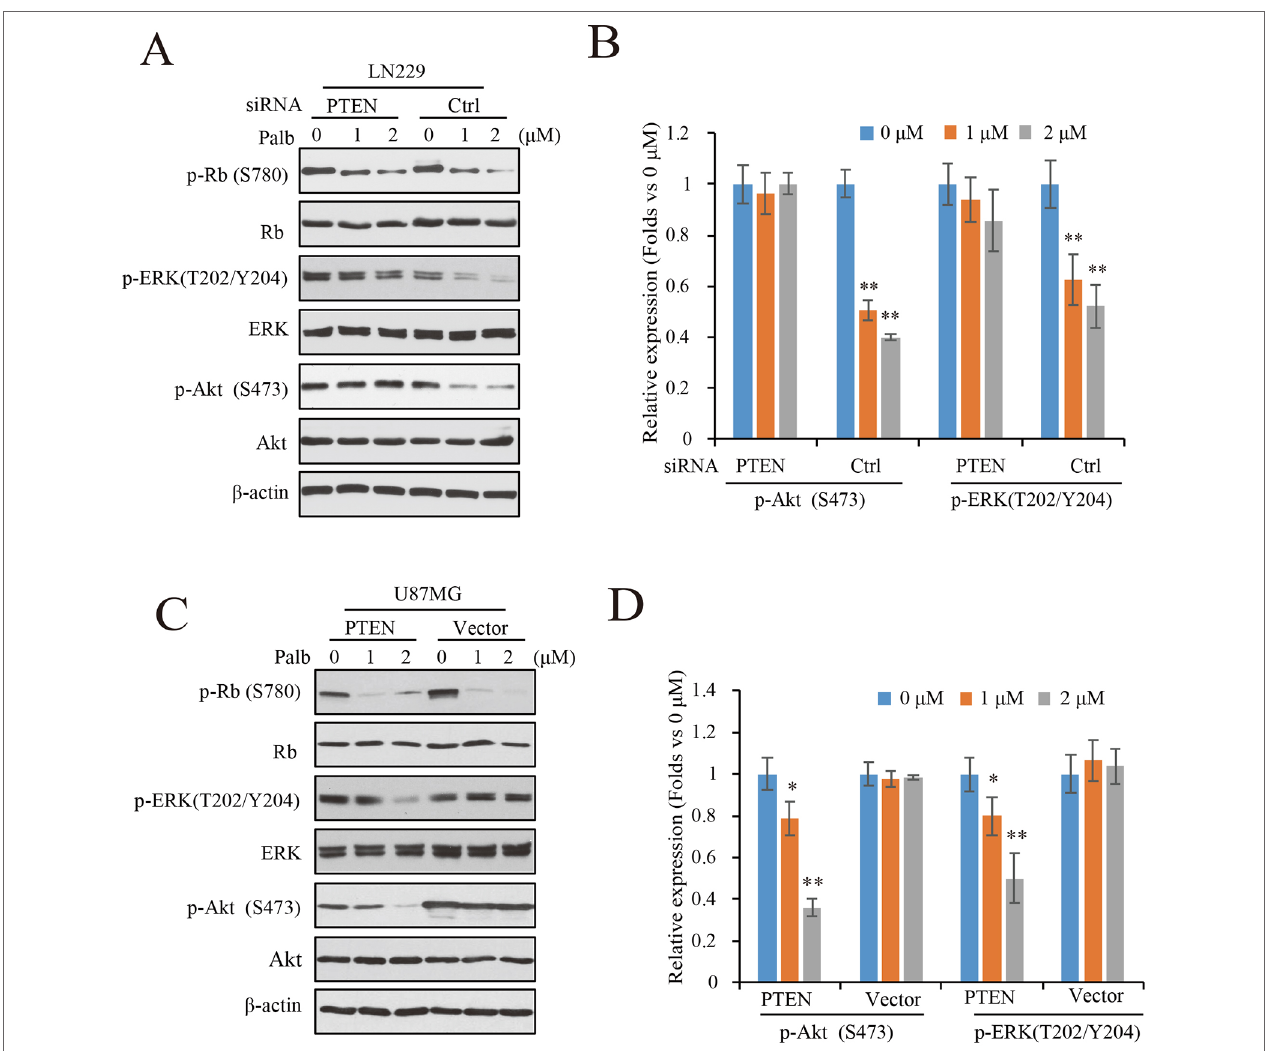
FIGURE 4 | Palbociclib blocks ERK and Akt signaling in the presence of PTEN. (a) Effects of palbociclib on the levels of p-ERK, p-Akt, as well as p-Rb in LN229 cells pre-treated by PTEN/control siRNA. Following siRNA treatment, the cells were subjected to palbociclib treatment for 24 h. Cell lysates were collected and analyzed by western blot assay. (B) Quantification of the blots in (a) Data are shown as mean ± SD (* P 0.05, ** P 0.01, one-way ANOVA, n = 3). (C) Effects of palbociclib on the levels of p-ERK, p-Akt, as well as p-Rb in U87MG isogenic cells. Cells were treated with palbociclib at indicated concentrations for 24 h. Cell lysates were collected and subjected to western blotting analysis with indicated antibodies. (D) Quantification of the blots in (C) . Data are shown as mean ± SD (* P 0.05, ** P 0.01, one-way ANOVA, n = 3).